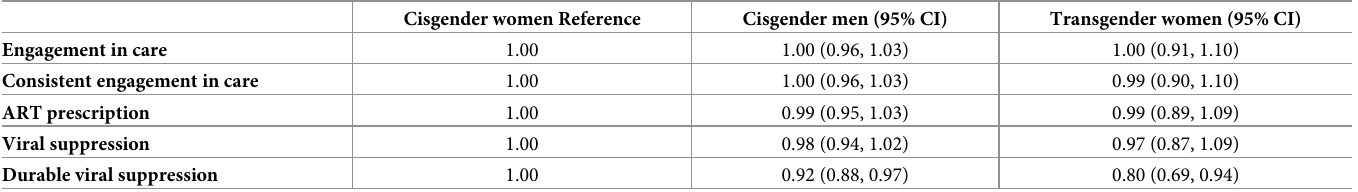
Table 6. Adjusted prevalence ratios of HIV care outcomes among Ryan White Part A clients, based on HIV